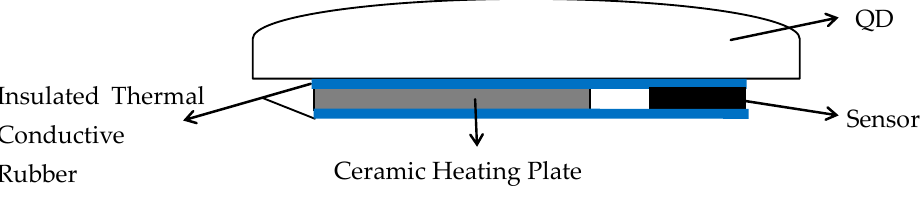
Figure 9. The layout of heater and sensor of temperature control for QD.